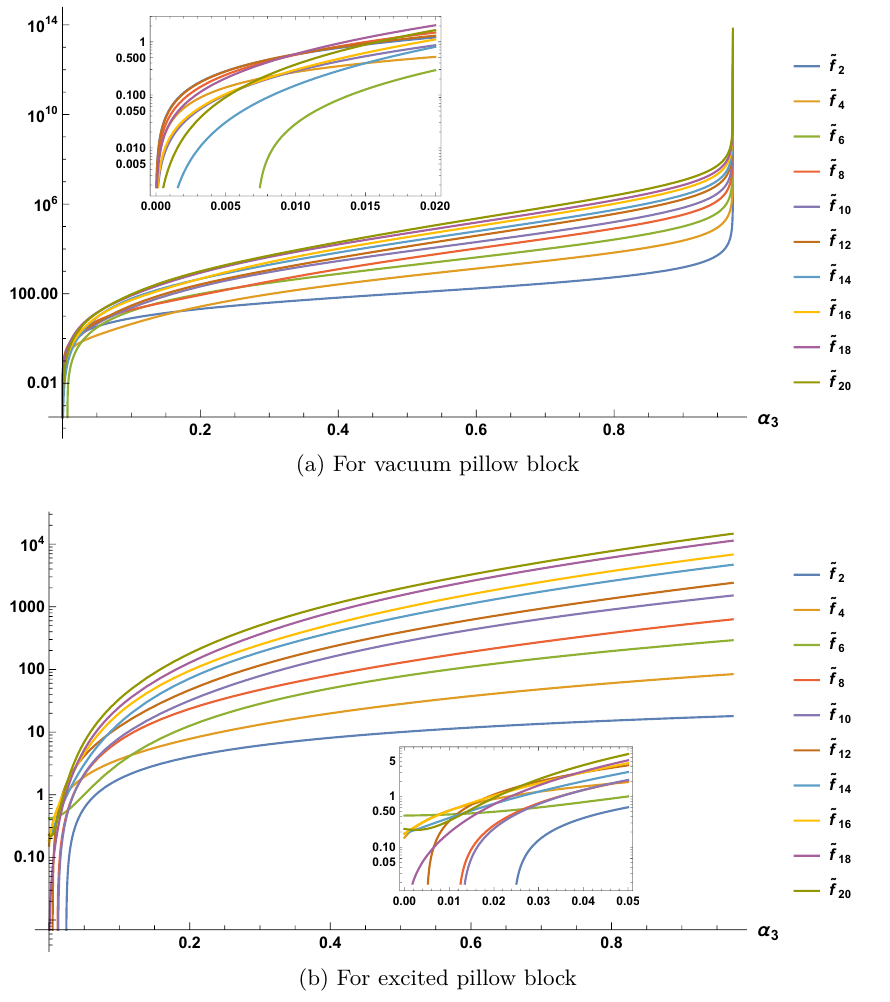
Figure 2 . First few non-vanishing q -expansion coefficients in the pillow blocks are plotted against α 3 . y -axes are taken to be